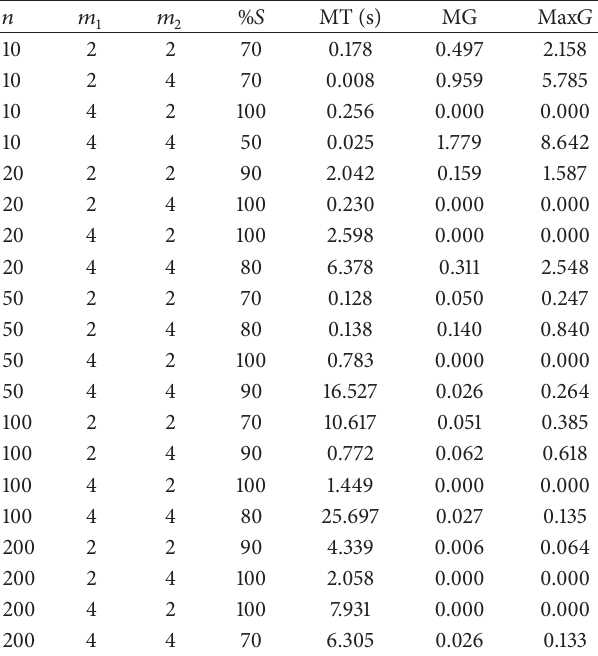
Table 2: Performance for 𝑎 = 𝑏 = 𝑐 = 20 and 𝑑 = 40